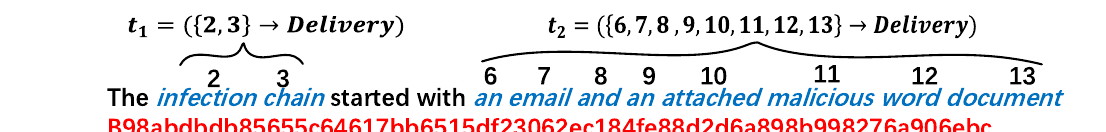
Fig. 4 An example of Delivery campaign stage. The red font represents the IOC, and the blue font is the campaign trigger